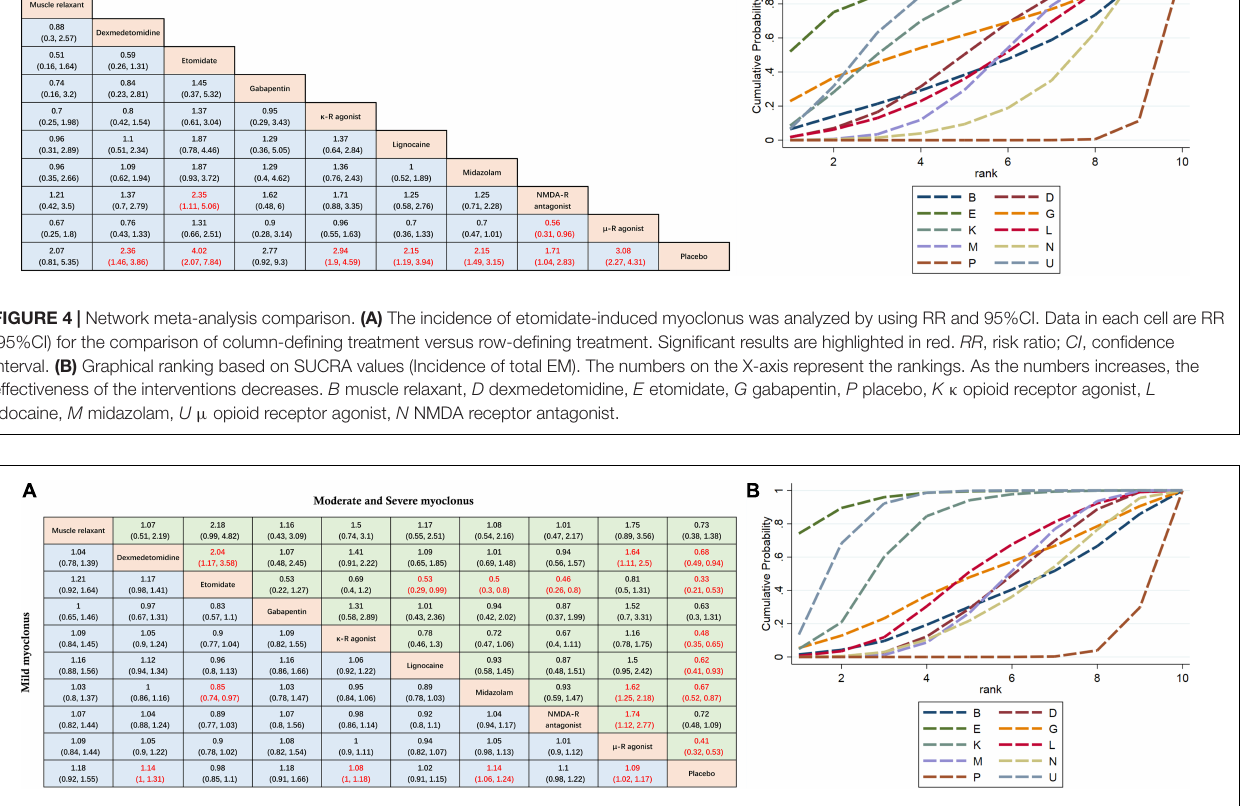
FIGURE 5 | Subgroup analysis of myoclonus of different degrees. (A) The incidence of myoclonus of different severity after etomidate induction was analyzed by using RR and 95%CI. Data in each cell are RR (95%CI) for the comparison of column-defining treatment versus row-defining treatment. Significant results are highlighted in red. RR , risk ratio; CI , confidence interval. (B) Graphical ranking based on SUCRA values (Incidence of moderate to severe EM). The numbers on the X-axis represent the rankings. As the numbers increases, the effectiveness of the interventions decreases. B muscle relaxant, D dexmedetomidine, E etomidate, G gabapentin, P placebo, K κ opioid receptor agonist, L lidocaine, M midazolam, U µ opioid receptor agonist, N NMDA receptor